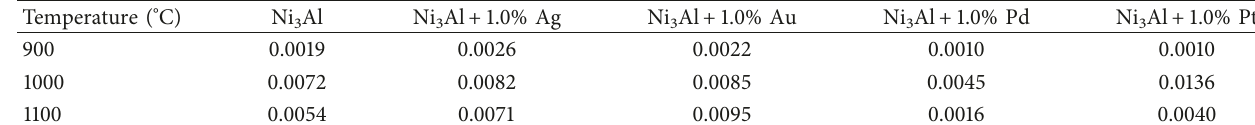
Table 3: Values of k p obtained from slopes of Figure 5.